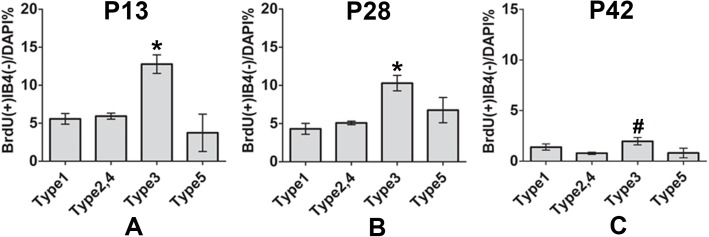
Spatio-temporal changes in the distribution of BrdU+ cells.Comparison of the percentages of BrdU+IB4- cells in Type 1, Type 2, 4, Type 3, Type 5 region at P13(A), P28(B) and P42 time point. #P > 0.05, *P < 0.05.